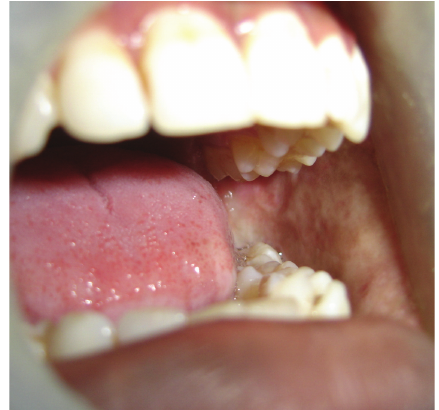
Figure 2: Bilateral oral submucous fibrosis (preop).